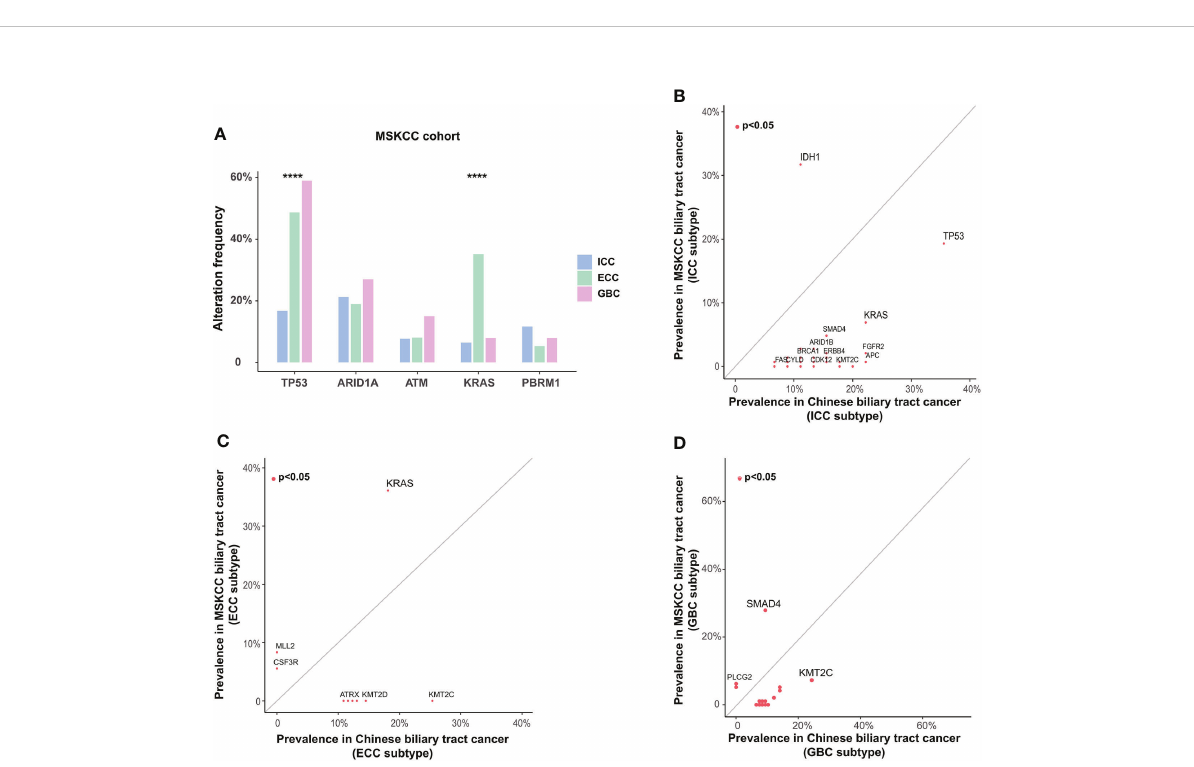
FIGURE 4 Differences in somatic alterations between Chinese and Western BTC patients. (A) Differences in somatic alterations between histological subtypes in the Western MSKCC cohort. **** p < 0.0001. Comparison of the prevalence of somatic alterations identi fi ed in (B) ICC, (C) ECC, and (D) GBC subtypes between the Chinese cohort and the Western MSKCC cohort. BTC, biliary tract cancer; MSKCC, Memorial Sloan Kettering Cancer Center; ICC, intrahepatic cholangiocarcinoma; ECC, extrahepatic cholangiocarcinoma; GBC, gallbladder